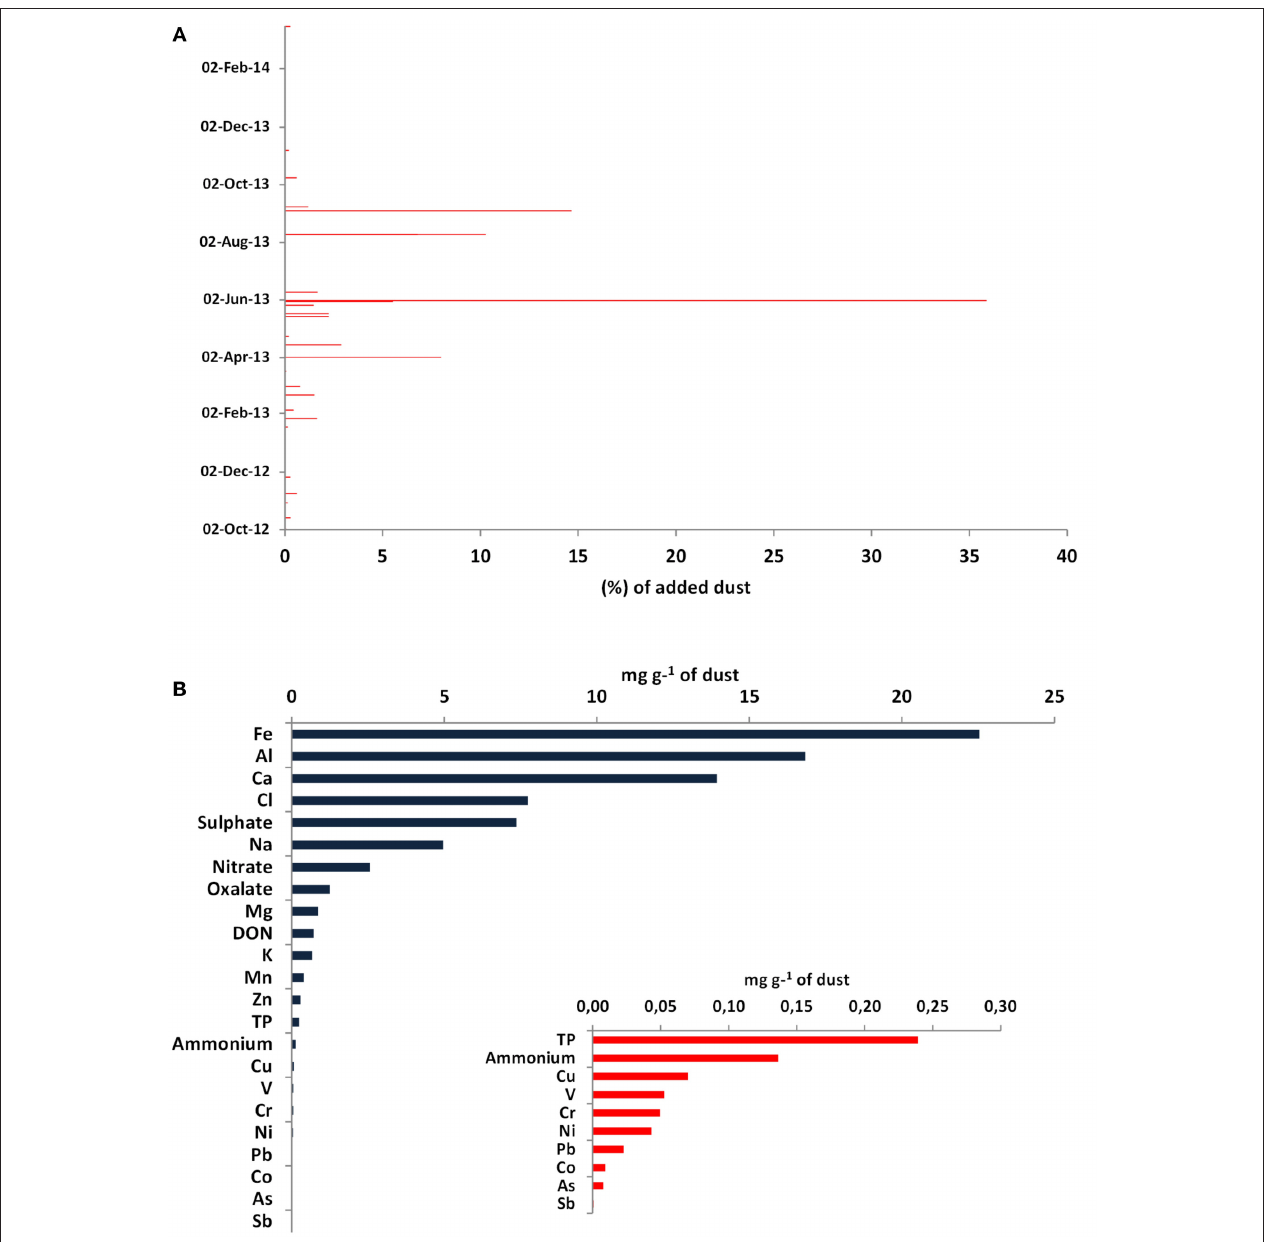
FIGURE 1 | (A) Temporal distribution of the collected dust deposition samples in Crete and Cyprus during a 1-year period (October 2012–November 2013). The dates correspond to the end of the dust collections, while the x axis represents the percentage contribution of each dust sample (in mass) to the total mass of the added dust, (B) Chemical characterization of the dust used in the mesocosm experiment. Only 8% of the dust mass was characterized.